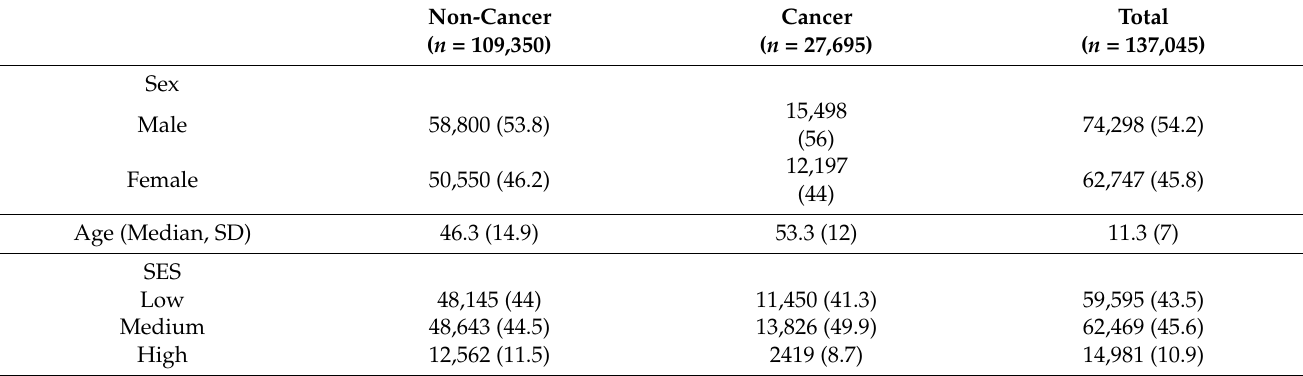
Table 1. Descriptive statistics of the selected AMORIS cohort, overall and divided by cancer